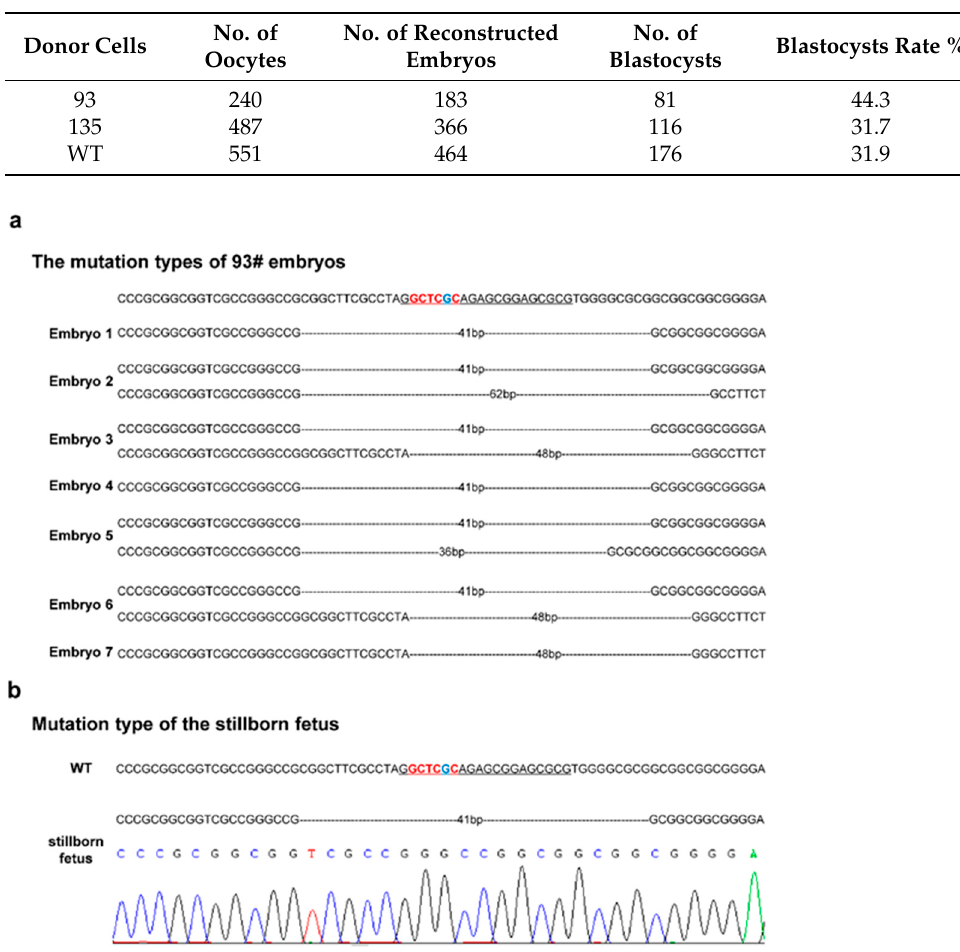
Table 1. In vitro development of NT embryos derived from single-cell clones 93 and 135.